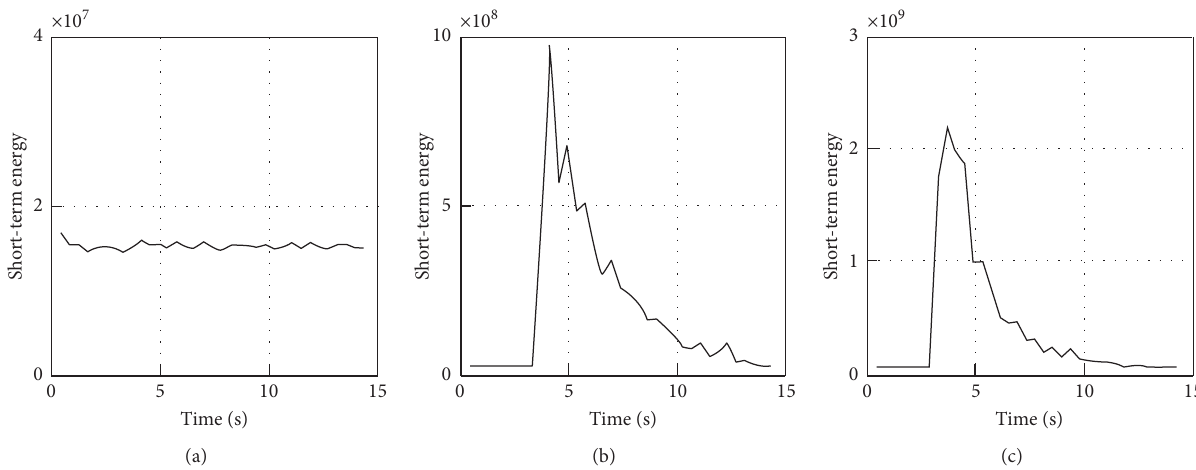
Figure 6: Short-term energy distribution of different fiber vibration signals. (a) Nonintrusion. (b) Tapping. (c) Climbing.